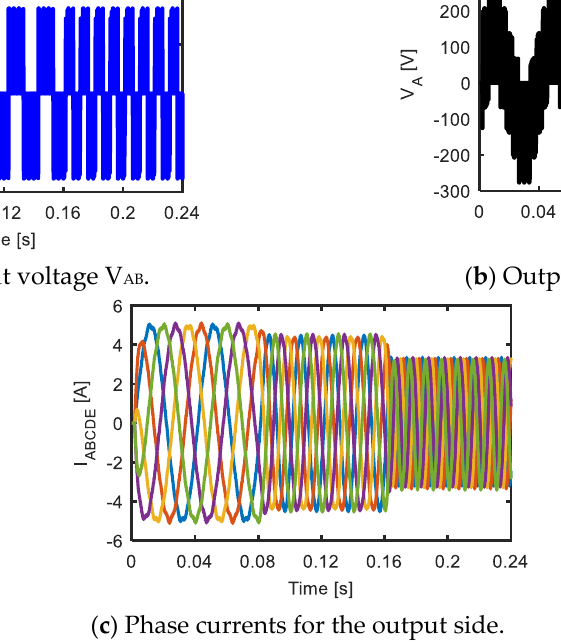
Figure 6. Simulation results for a static R-L load with output frequencies of 25, 50 and 100 Hz.